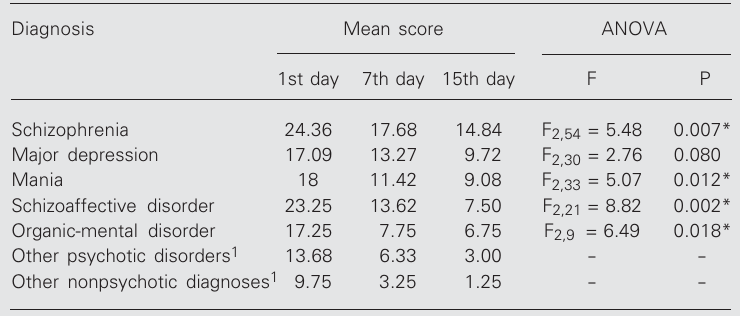
Table 4. Brief Psychiatric Rating Scale evaluation during the first two weeks of hospitalization.